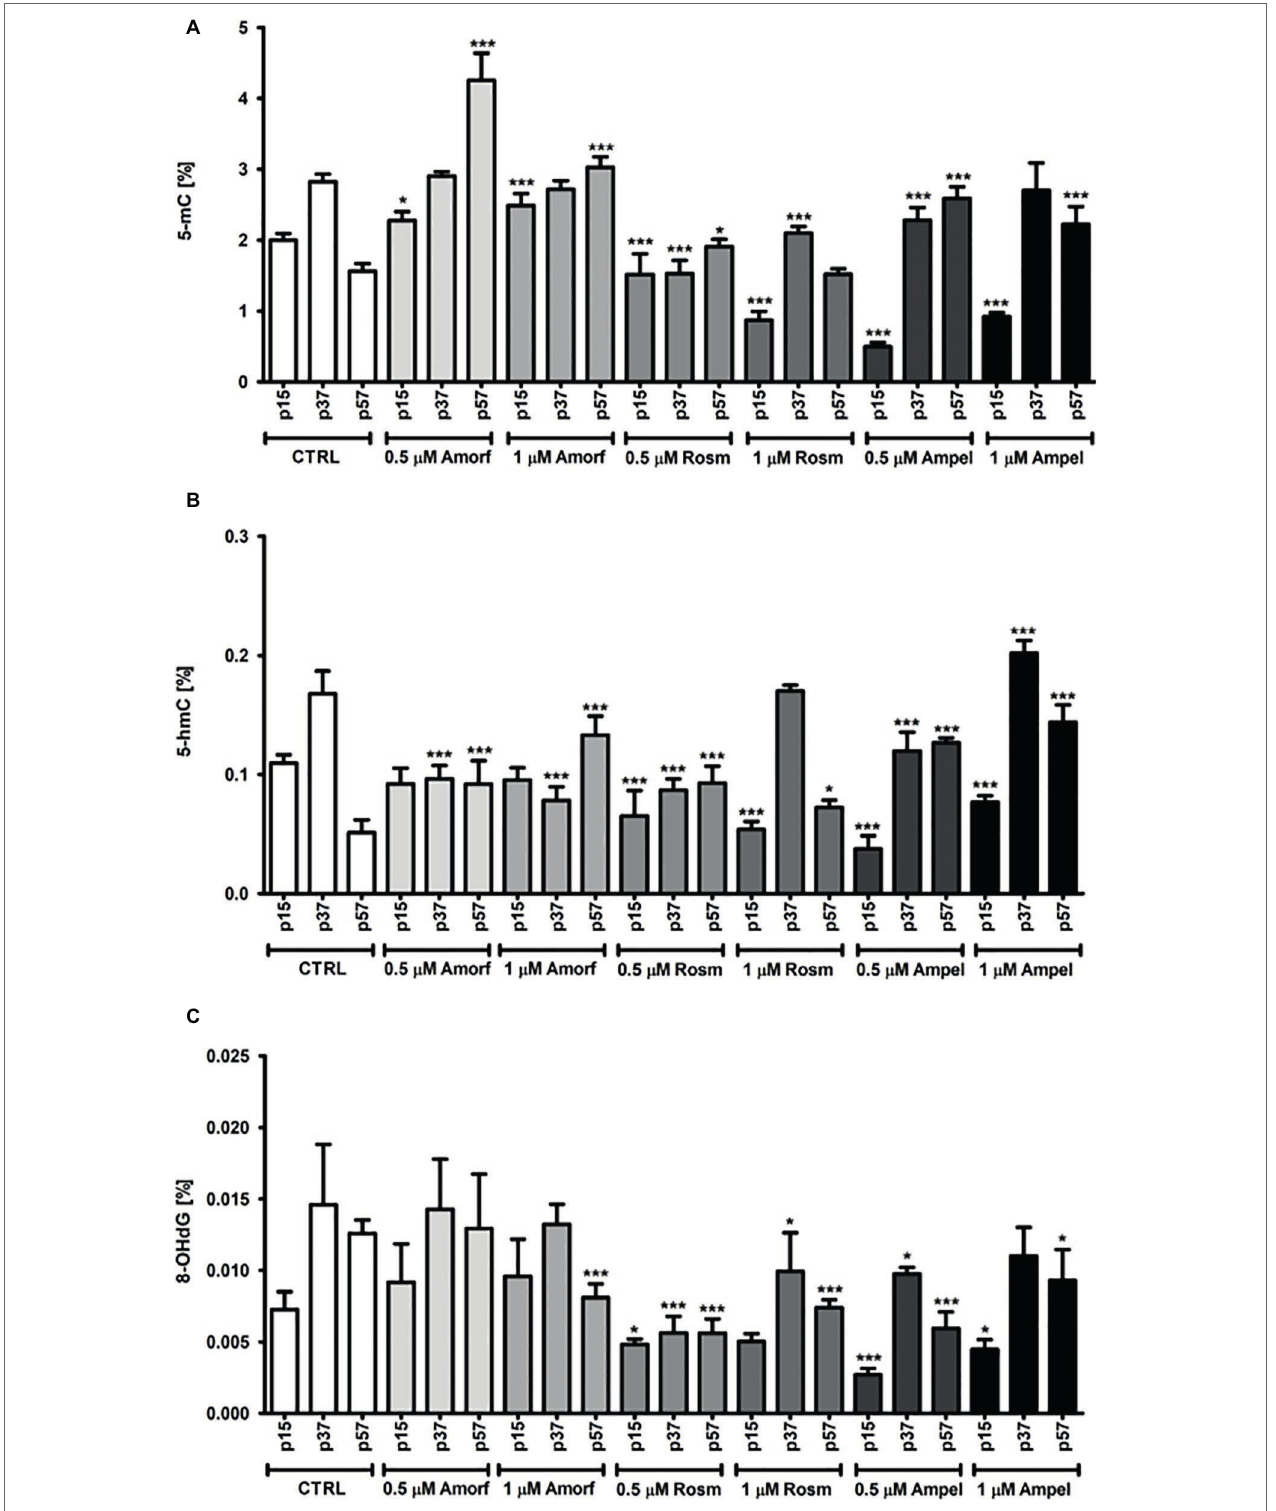
FIGURE 6 | Effect of continuous exposure to test compounds on the levels of 5-mC (A) , 5-hmC (B) , and 8-OHdG (C) in DNA isolated from serially passaged PCS cells. The bars indicate the SEM, n = 3, *** p < 0.001, * p < 0.05 compared to passages, p15, p37, and p57, at control growth conditions, respectively (ANOVA and Dunnett’s a posteriori